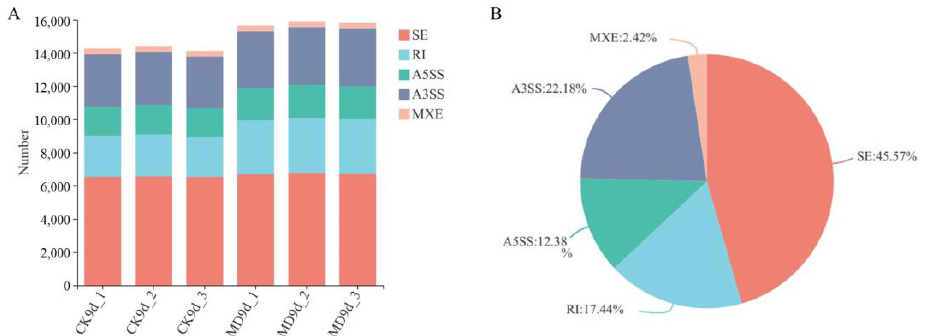
Figure 1. Summary of AS type of rice inferior spikelets under CK and MD conditions. ( A ) Number of the identified AS events. SE, skipped exon; A5SS, alternative 5 ′ splice site; A3SS, alternative 3′ splice site; MXE, mutually exclusive exon; RI, retained intron; ( B ) Summary of AS type, represented as percentages.